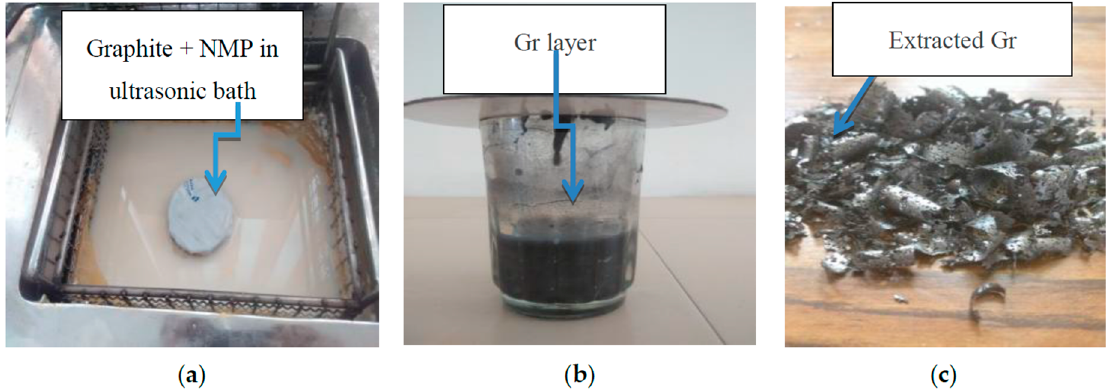
Figure 1. Extraction of Gr. ( a ) Sonication of graphite and NMP; ( b ) Formation of Gr layer; and ( c ) Extracted Gr.